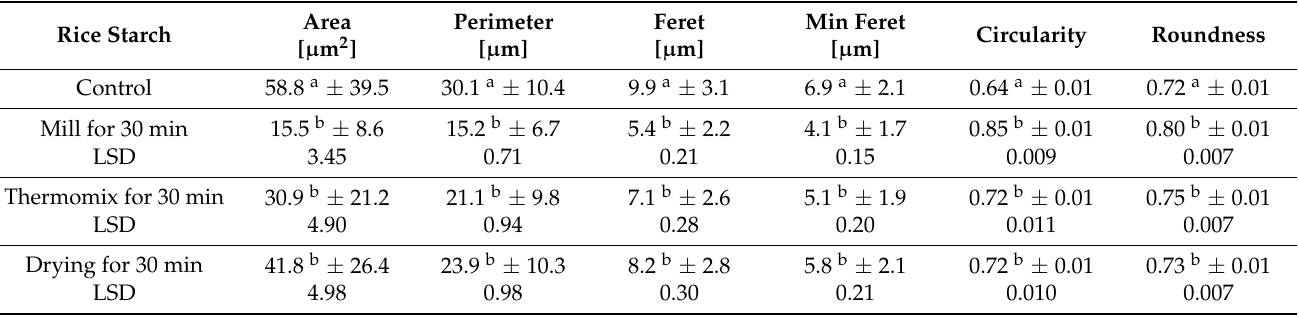
Table 5. Comparison of measurements of rice starch granules before (control) and after grinding and drying.